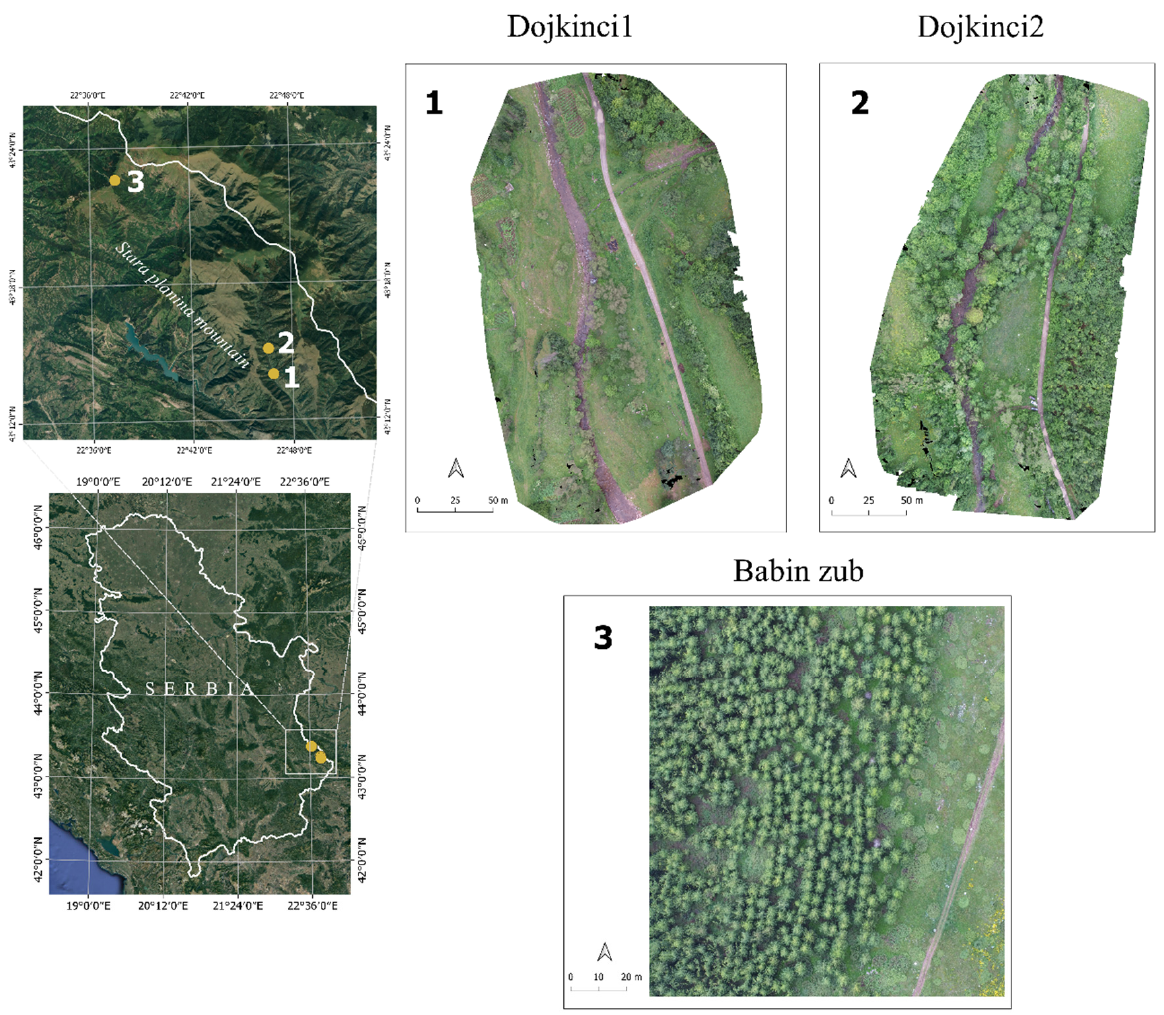
Figure 1. The map of Serbia ( left ) with three study sites representing the geographical position of study areas captured by the UAV ( right ).